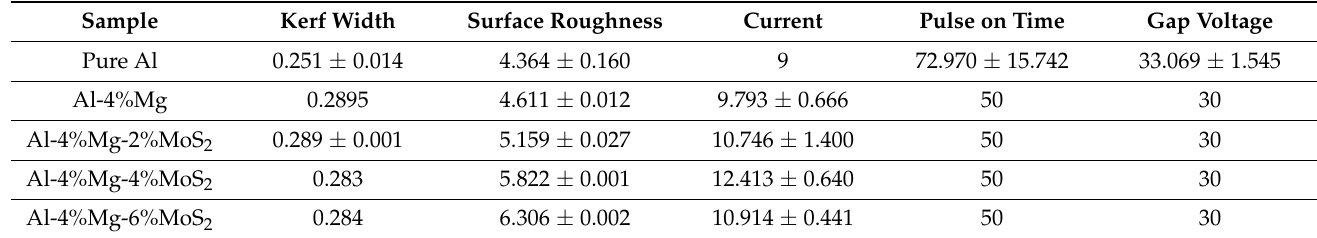
Table 3. Machining parameters range obtained using NSGA-II.